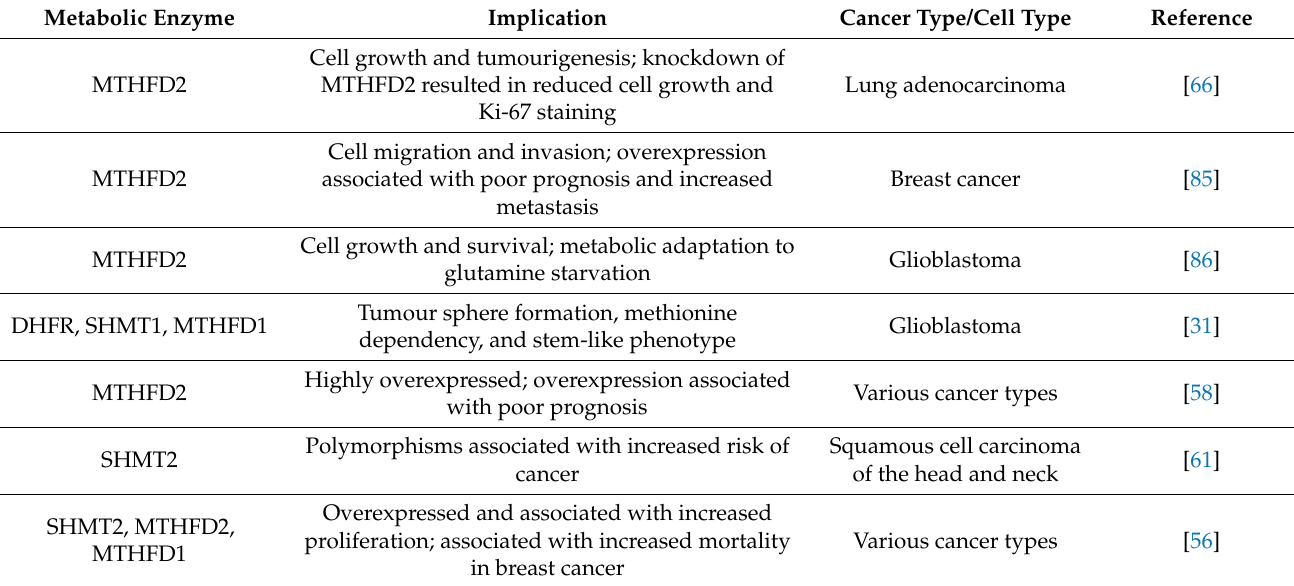
Table 1. Summary of described 1-C metabolism and purine synthesis associated vulnerabilities in cancer. Metabolic